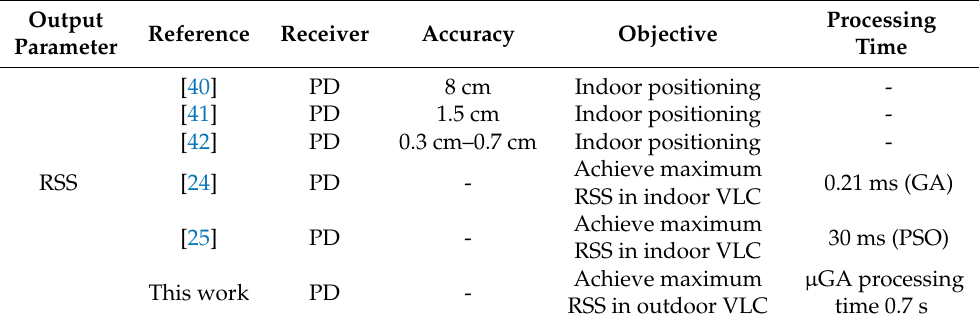
Table 3. A review of the published state-of-the-art in VLC (in terms of the